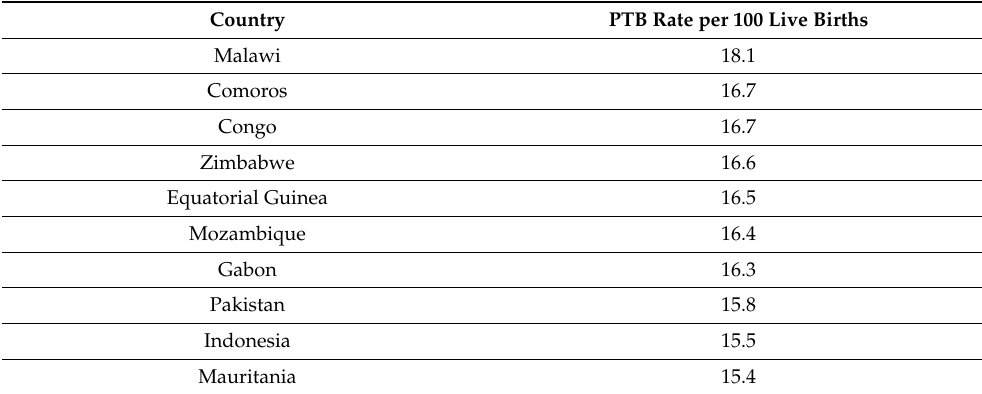
Table 2. Countries with highest rates of PTB per 100 live births